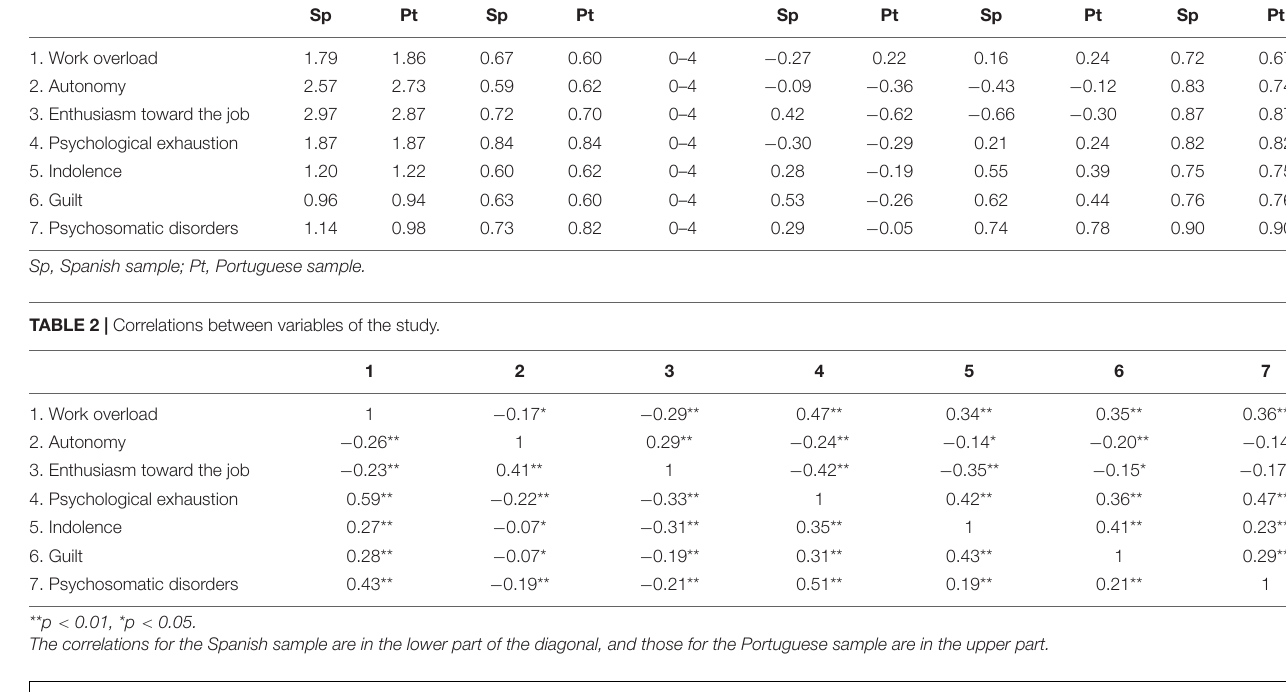
TABLE 1 | Means, standard deviations, range, skewness, kurtosis and internal consistencies (Cronbach’s alphas), for the two study samples. Mean Sd Range Kurtosis Skewness Alpha